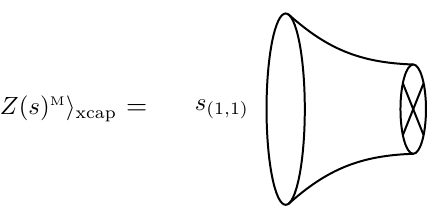
Figure 12 . We depict the crosscap spacetime amplitude with an FZZT boundary and identity brane matter boundary condition. The boundary cosmological constant is µ B ( s ) and the fixed length version is obtained by integrating over s